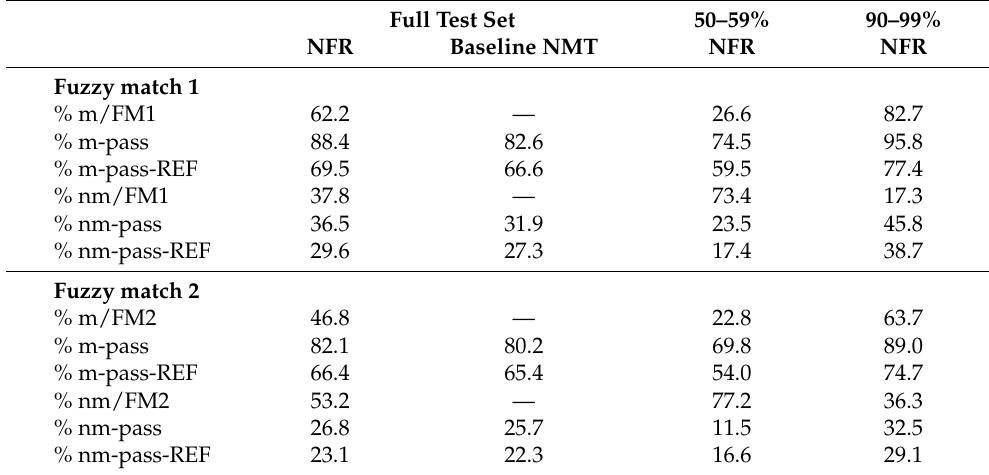
Table 12. Analysis of match (m) and no-match (nm) tokens in FMs and whether they appeared in the MT output ( pass ) as well as in the reference translation